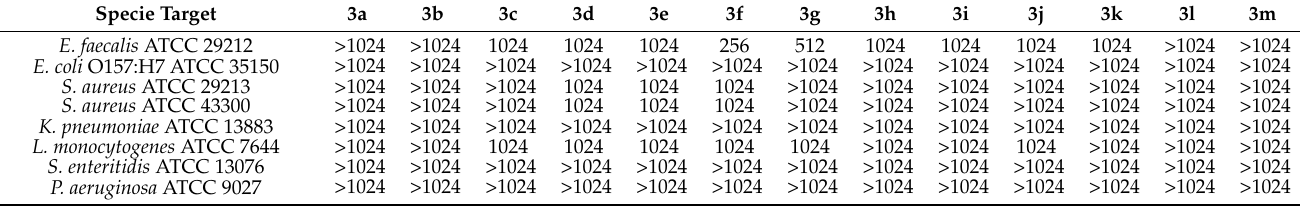
Table 3. Antibacterial activity of sucrose-based compounds (MIC values are reported in µ g/mL). Specie